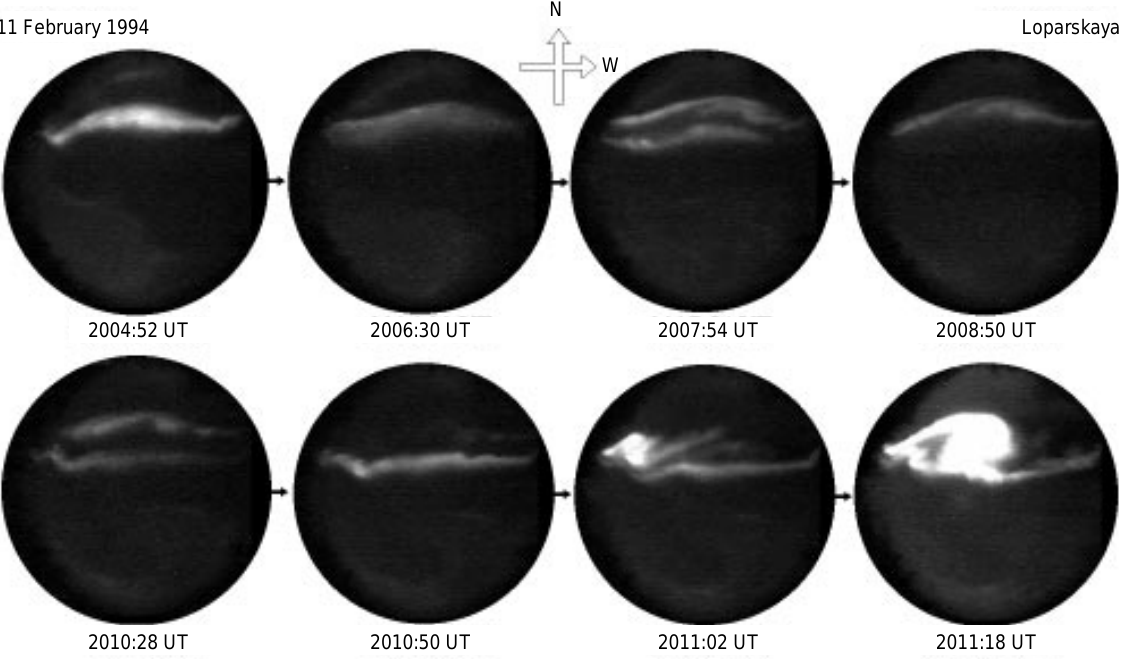
Fig. 4. Prebreakup activity during the MAAS interval on February 1994 showing the variations of the luminosity in several auroral arcs and the formation of the westward travelling